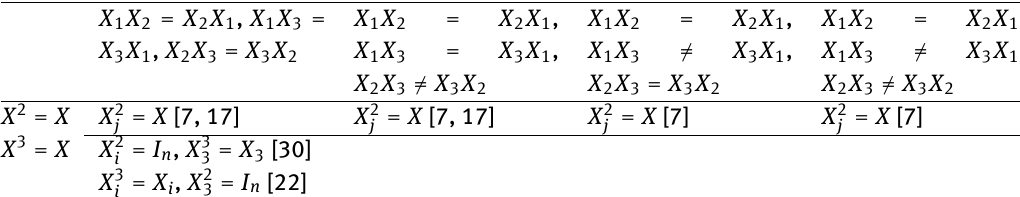
Table 2: Summary of the results in which the linear combinations of the form (2) are considered X 1 X 2 = X 2 X 1 , X 1 X 3